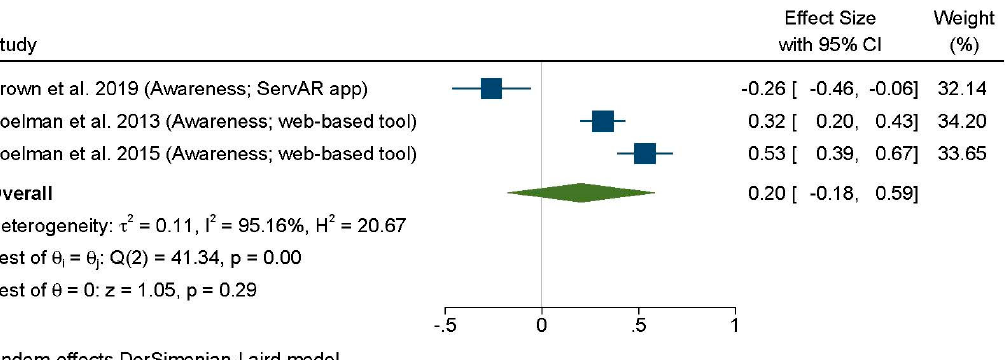
Figure 3. Forest plot for the analysis of all comparisons examining the effects of portion control tools on portion size awareness using random-effects meta-analysis. Contributing comparisons are represented by a filled square with horizontal lines, where the area of the square depicts the contribution of the study to the full analysis, and the horizontal lines indicate the 95% CIs for each study. Studies displaced to the left of a 0 line demonstrate a finding in favor of the tool not improving portion size learning or awareness, whereas those to the right demonstrate a finding in favor of the tool enhancing portion size learning or awareness. The diamond at the base of the plot represents the combined effect (Standardized Mean Difference) with 95% CIs.